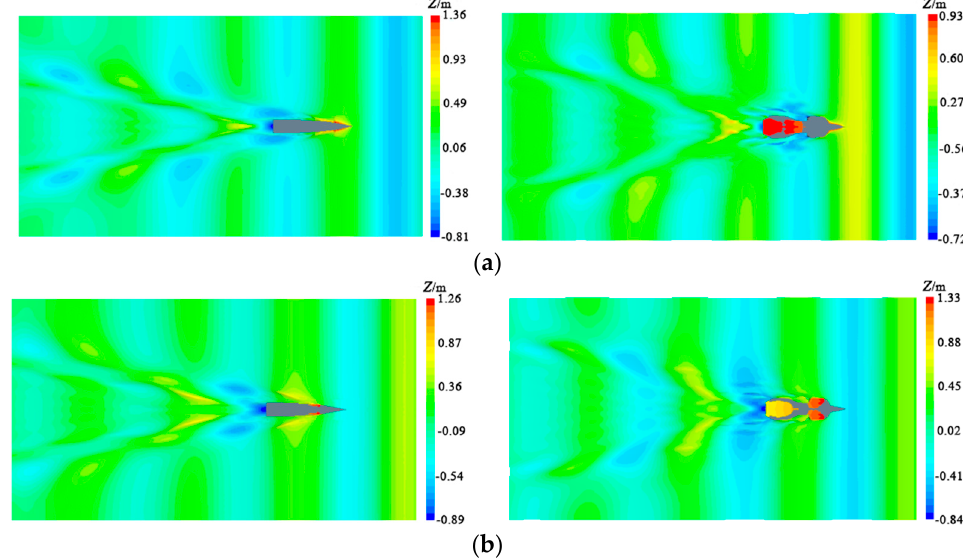
Figure 26. The wave patterns of the monohull and pentamaran in regular waves under case 1: ( a ) bow encounters a wave crest; ( b ) bow encounters a wave trough.